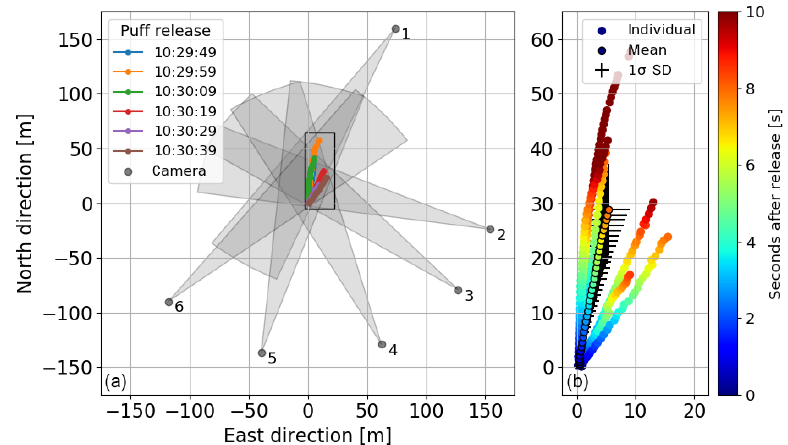
Figure 9. Horizontal projection of the CM trajectories of the six puffs observed with six SO 2 cameras. The left panel shows an overview of the camera positions relative to the reconstructed trajectories. The right panels shows a blow-up of the rectangular area marked in the left panel. The colour code represents the travel time since release. The mean trajectory and its standard deviation are displayed with black pluses.